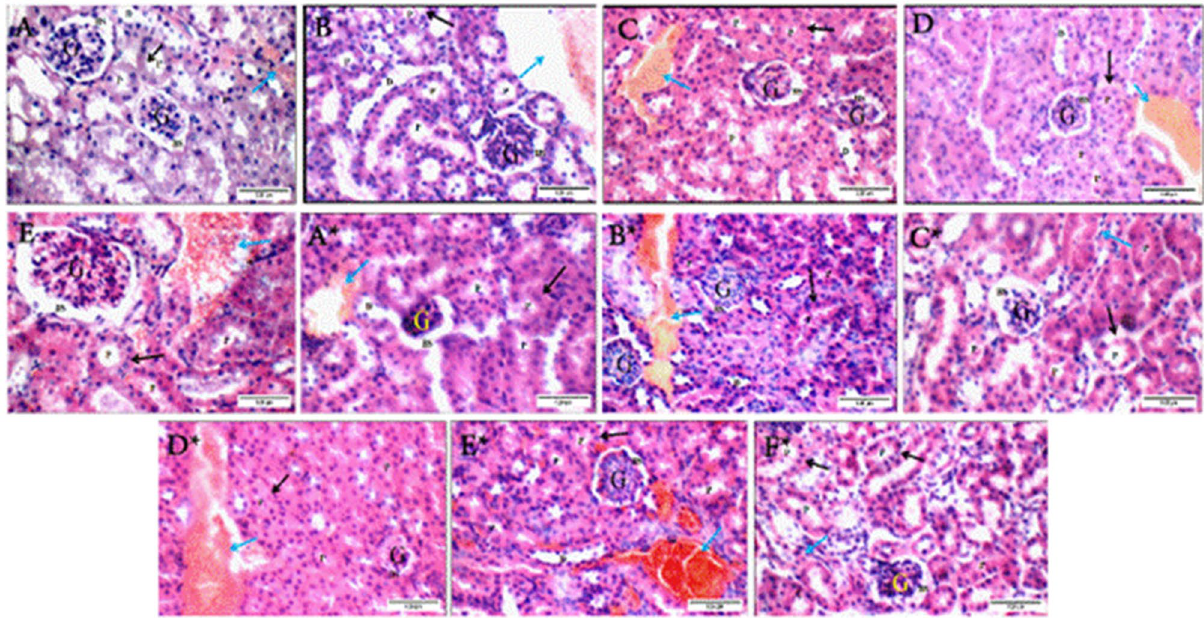
Figure 10. Kidney sections of non-infected groups: ( A ) control group showing average glomeruli (G) with average Bowman’s spaces (BS), average proximal tubules (P) with preserved brush borders (black arrow), average distal tubules (D), and average interstitial blood vessels (blue arrow), ( B ) BV group showing average glomeruli (G) with average Bowman’s spaces (BS), proximal tubules (P) with mildly edematous epithelial lining (black arrows), and markedly congested interstitial blood vessels (blue arrow), ( C ) irradiated BV group showing average glomeruli (G) with average Bowman’s spaces (BS), proximal tubules (P) with average epithelial lining (black arrow), average distal tubules (D), and mildly congested interstitial blood vessels (blue arrow), ( D ) CS-NPs group showing average glomeruli (G) with average Bowman’s spaces (BS), proximal tubules (P) with average epithelial lining (black arrows), and mildly congested interstitial blood vessels (blue arrow), ( E ) BV-loaded CS-NPs group showing average glomeruli (G) with average Bowman’s spaces (BS), proximal tubules (P) with scattered apoptotic epithelial lining (black arrow), and markedly dilated congested blood vessels (blue arrow). Kidney sections of infected groups with S. aureus : ( A* ) no treatment group showing scattered atrophied glomeruli (G) with widened Bowman’s spaces (BS), proximal tubules (P) with average epithelial lining (black arrow), and mildly congested blood vessels (blue arrow), ( B* ) BV group showing average glomeruli (G) with average Bowman’s spaces (BS), proximal tubules (P) with average epithelial lining (black arrow), and mildly congested blood vessels (blue arrow), ( C* ) irradiated BV group showing atrophied glomeruli (G) with widened Bowman’s spaces (BS), proximal tubules (P) with scattered apoptotic epithelial lining (black arrow), and average interstitium (blue arrow), ( D* ) CS-NPs group showing scattered small-sized glomeruli (G) with narrow Bowman’s spaces (BS), proximal tubules (P) with scattered apoptotic epithelial lining (black arrow), and mildly congested blood vessels (blue arrow), ( E* ) BV-loaded CS-NPs group showing average glomeruli (G) with average Bowman’s spaces (BS), proximal tubules (P) with average epithelial lining (black arrow), and mildly congested interstitial blood vessels (blue arrow), ( F* ) antibiotic group showing average glomeruli (G) with average Bowman’s spaces (BS), proximal tubules (P) with average epithelial lining (black arrow), and average interstitium (blue arrow) (H&E X 400). – BV: Bee venom, CS-NPs: Chitosan nanoparticles, BV-loaded CS-NPs: Bee venom loaded Chitosan nanoparticles, S. aureus: Staphylococcus aureus, H&E: Hematoxylin and phase response. The increase of IL-6 levels in addition to the thymic atrophy and damage of the spleen caused by S. aureus infection 42,44 , only seemed to decrease in the case of the BV-loaded CS-NPs treated group, which had average spleen and thymus sections and an IL-6 level that was very close to the negative control. All of the other drugs caused a significant increase in IL-6 levels in the infected groups. The irradiated BV also showed the most significant increase treated group, whose spleen sections along with the CS-NPs treated group sections, had mild congestions and excess giant cells. Thymus sections of the irradiated BV group also showed cortical apoptosis and increased medullary reticular cells. The overall summary of results suggested that, unlike radiation, loading the BV on CS-NPs gave it the most efficient antibacterial activity without triggering an inflammatory response or causing major damage to the thymus or spleen. In conclusion, BV-loaded CS-NPs have shown relatively better results than the other alternatives, which are native BV and irradiated BV. The In‑vitro study showed that the antibacterial effect of BV-loaded CS-NPs was greater than the alternatives. Furthermore, its cytotoxic effect was far less than the native and irradiated BV. These outcomes reinforce that BV-loaded CS-NPs may indeed be an adequate alternative to antibiotics and could replace them with some dedicated search.